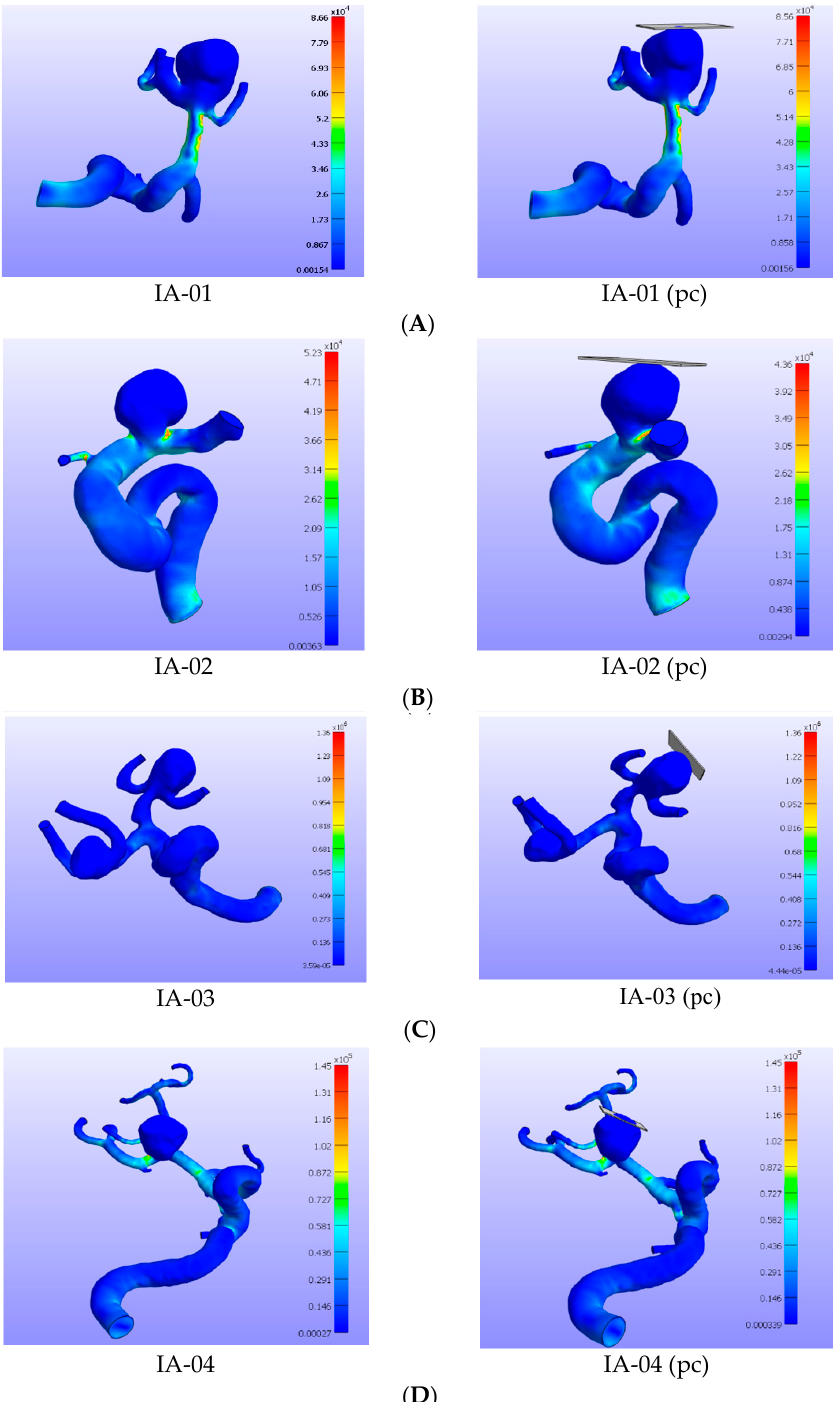
Figure 2. Finite element simulations of effective stress (Pa) on patient-specific unruptured intracranial aneurysms, where the panels on the left are aneurysms without constraint and on the right-side are the respective aneurysms with plane contact (pc) constraint for each patient. The simulations were performed under a uniform internal pressure of 120 mmHg. The cases IA-01 ( A ), IA-03 ( C ), and IA-04 ( D ) are middle cerebral artery aneurysms, and IA-02 ( B ) is an internal carotid artery aneurysm. The panels for ( A ) and ( B ) illustrate that maximum effective stress was decreased more when the aneurysm was constrained by a plane contact than that in the cases of an aneurysm with no contact. No noticeable change in maximum effective wall stress for the third ( C ) and fourth ( D ) panels were observed between the aneurysm without contact and the aneurysm with plane